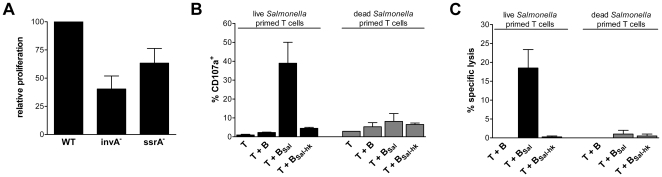
Induction of CTL response against Salmonella by B cells requires uptake of living Salmonella.(A) CD8+ T cells were labeled with CFSE and cultured with B cells that had phagocytosed either wild type Salmonella (WT), mutant for SPI-1 (invA−) or SPI-2 (ssrA−). Proliferation was measured after 6 days. Data shown are proliferation of CD8+ cells relative to wild type proliferation and are of two different donors; error bars are SEM. (B) Salmonella-specific T cells that were primed with B cells that had either internalized living (left panel) or dead Salmonella (right panel) were sorted and restimulated with B cells (T + B), B cells that had internalized living Salmonella (T + BSal) or dead Salmonella (T + BSal-hk). Degranulation was analyzed as CD107a expression by CD8+ T cells. (C) CD8+ T cell mediated kill was measured as the release of 51Cr by B cells. (B–C) Data are expressed as mean ± SEM, from four (live Salmonella primed) or two (dead Salmonella primed) independent experiments using material from different healthy donors.